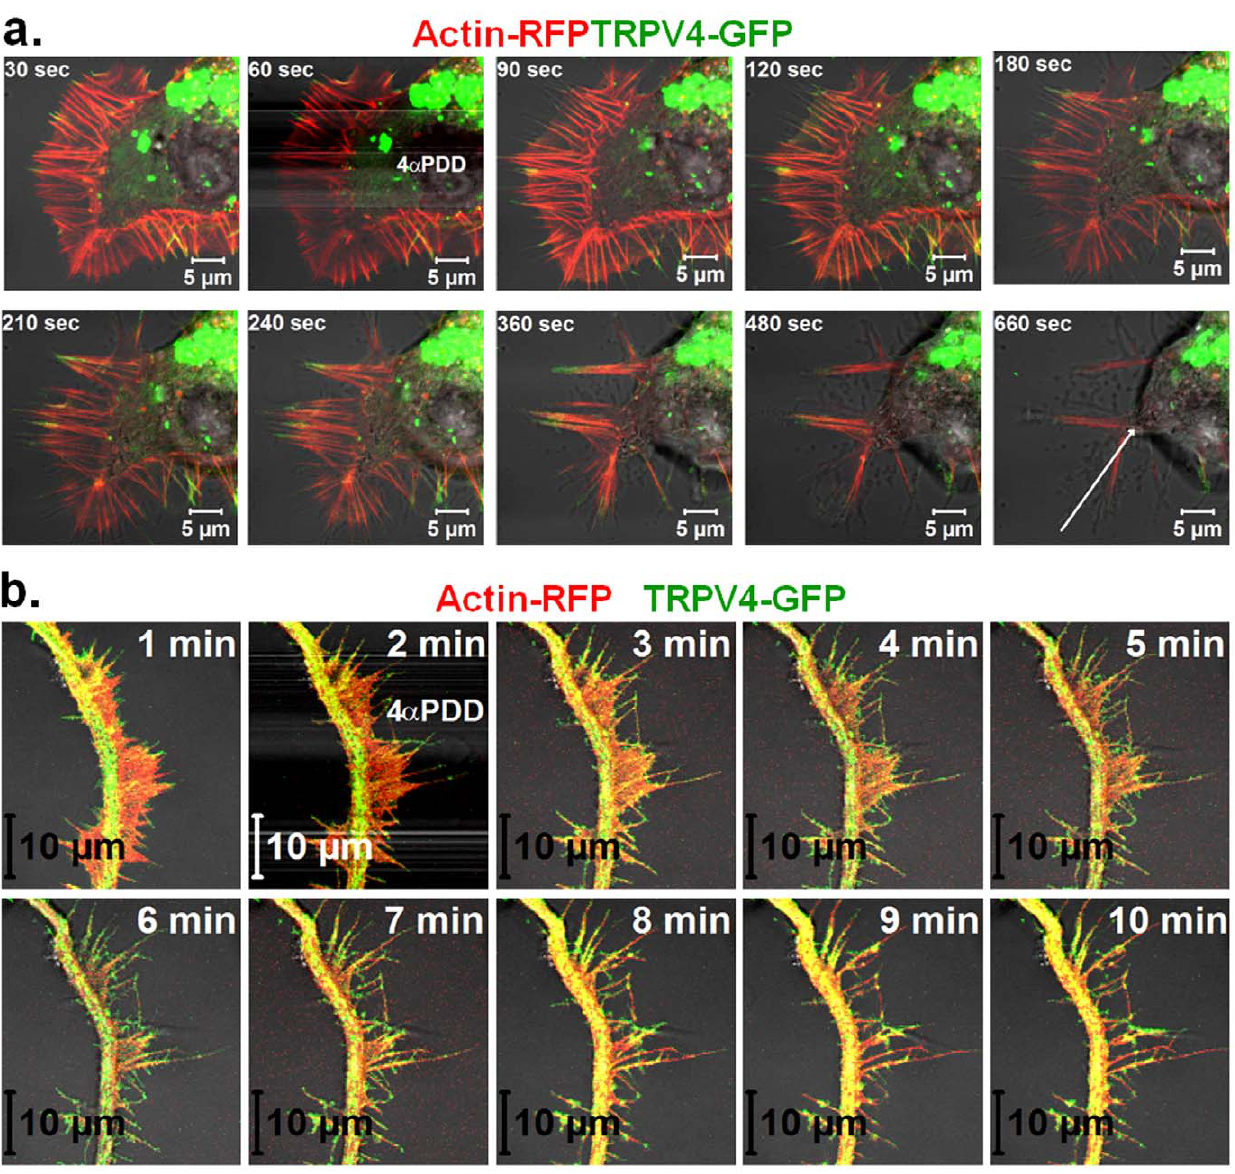
Figure 5. Activation of TRPV4 results in reorganization of actin cytoskeleton. Shown are the confocal images of live F11 cells expressing TRPV4-GFP (green) and Actin-RFP (red). a. Activation of TRPV4 results in merging of several actin-ribs at the tips and further transition of lamellipodial structures to filopodial structures. The arrow indicates the region and direction of the cell retraction at the same time. b. Activation of TRPV4 results in lateral initiation of filopodial structures from neurites and further elongation of them.